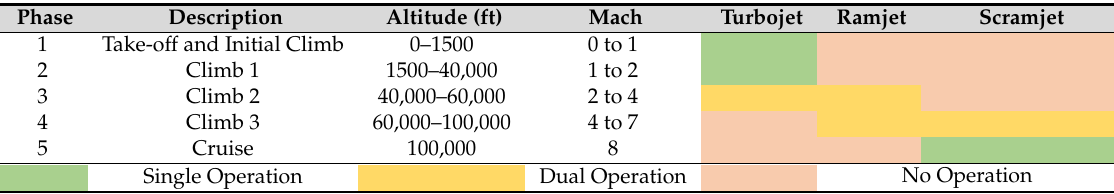
Table 1. Concept aircraft target flight